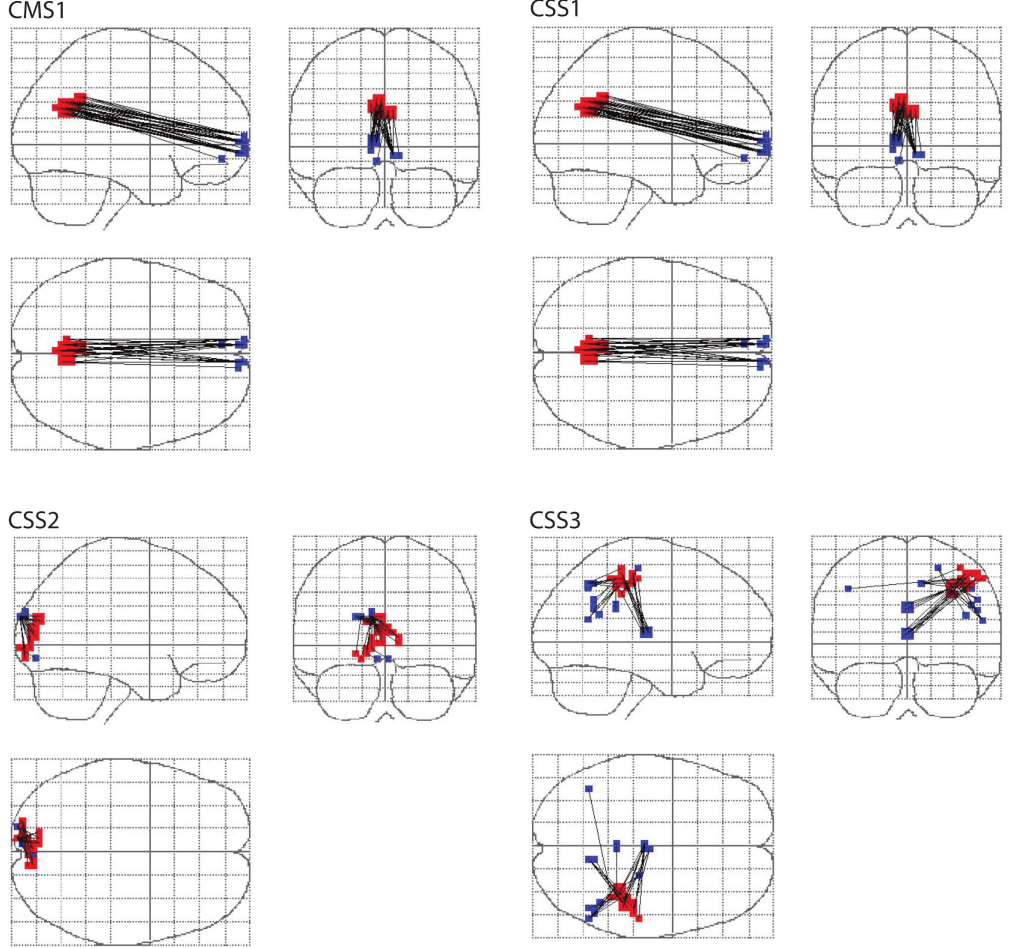
Figure 9. Networks of connectivity change. Altered functional connectivity identified by the CSS and CMS statistics (red) with the pseudo thresholded changes that contribute to these clusters (blue). It should be noted here that only whole clusters, rather than individual connections, can be deemed to be significant. doi:10.1371/journal.pone.0098697.g009 PLOS ONE |